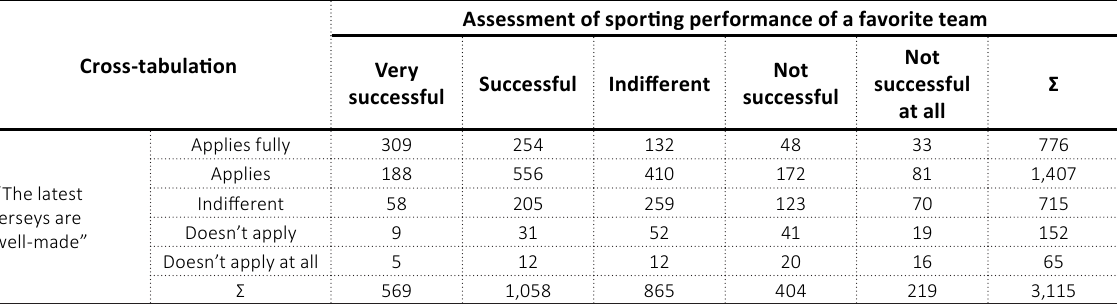
Table 3. Cross-tabulation of assessment of sporting performance and satisfaction with the design of the jerseys